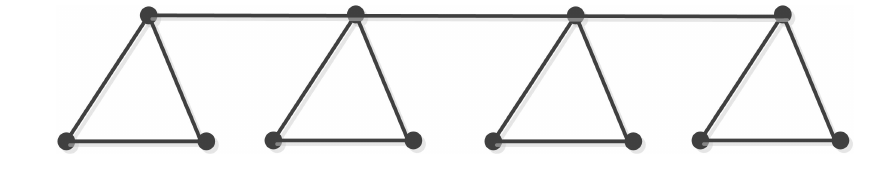
Fig. 7 The nano structures bridge graph G d ( K 3 , v